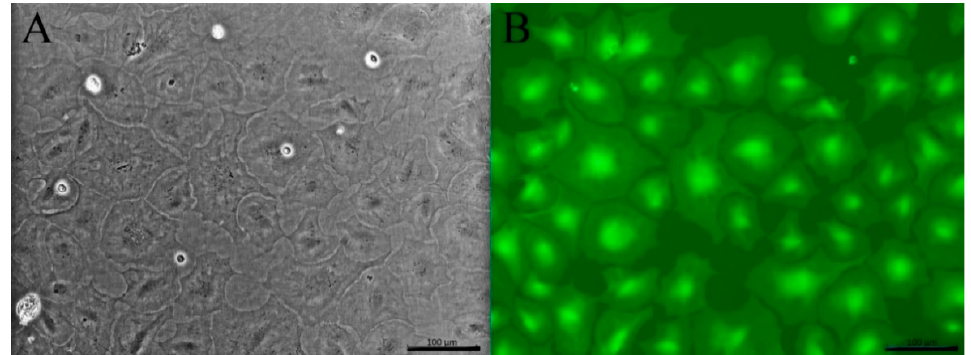
Figure 4. Cell morphology of the established LG-1 cell line. ( A ) Light microscopy. ( B ) The cells were stained with the live cell stain Calcein-AM and visualized by fluorescence microscopy. Scale bar = 100 µm Microscope: Leica DMIL .